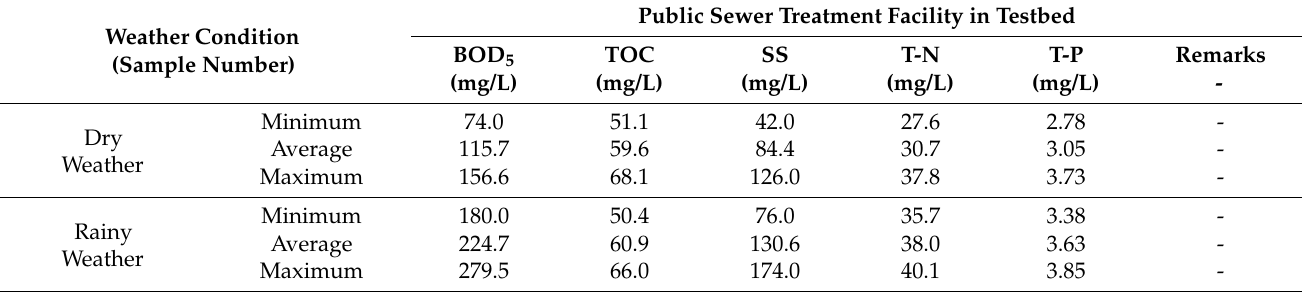
Table 2. Water quality of raw wastewater associated with different weather conditions in